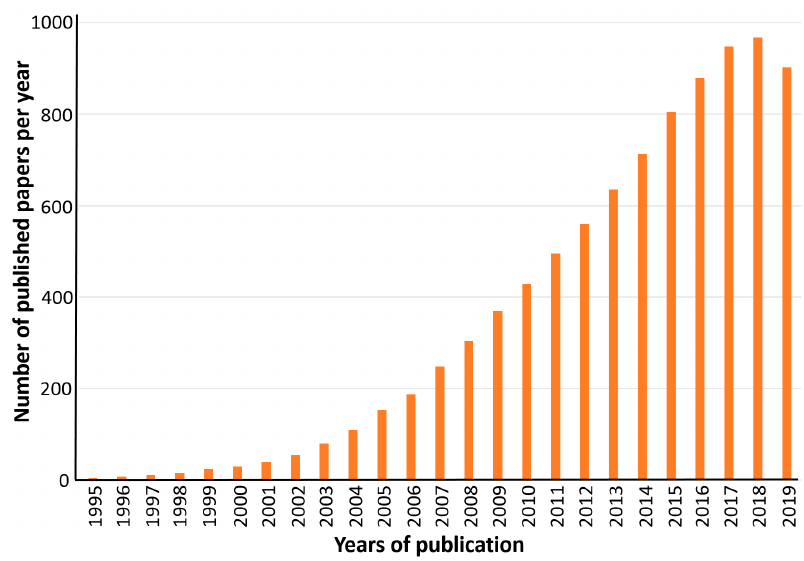
Figure 1. The number of published papers mentioning “magnetic nanoparticles” derived from statistics provided by Web of Science. The search was performed for the key words “magnetic nanoparticles” in the topic. Note the dramatic increase of the publications related to magnetic nanoparticles (the statistics for 2019 was not complete).